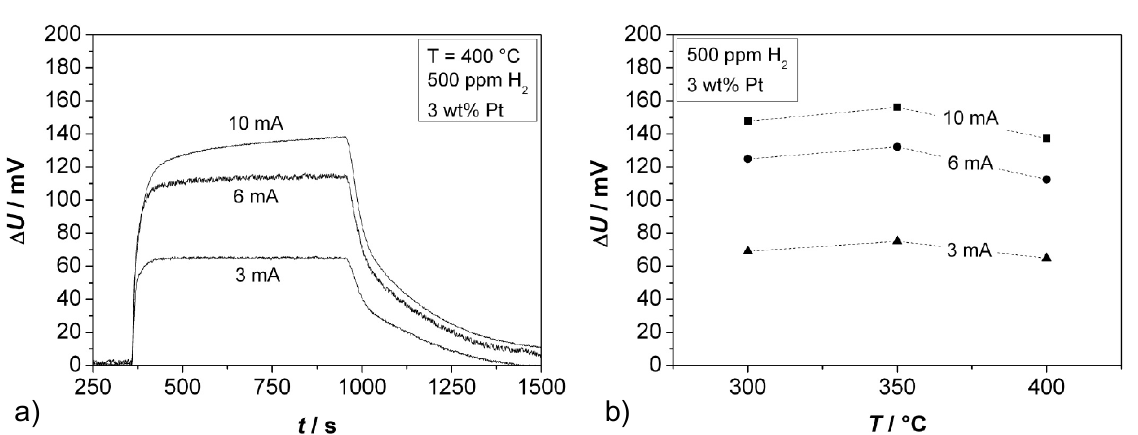
Figure 8. (a) Sensor response Δ U to an addition of 500 ppm H (b) Dependence of Δ U upon temperature and Cr